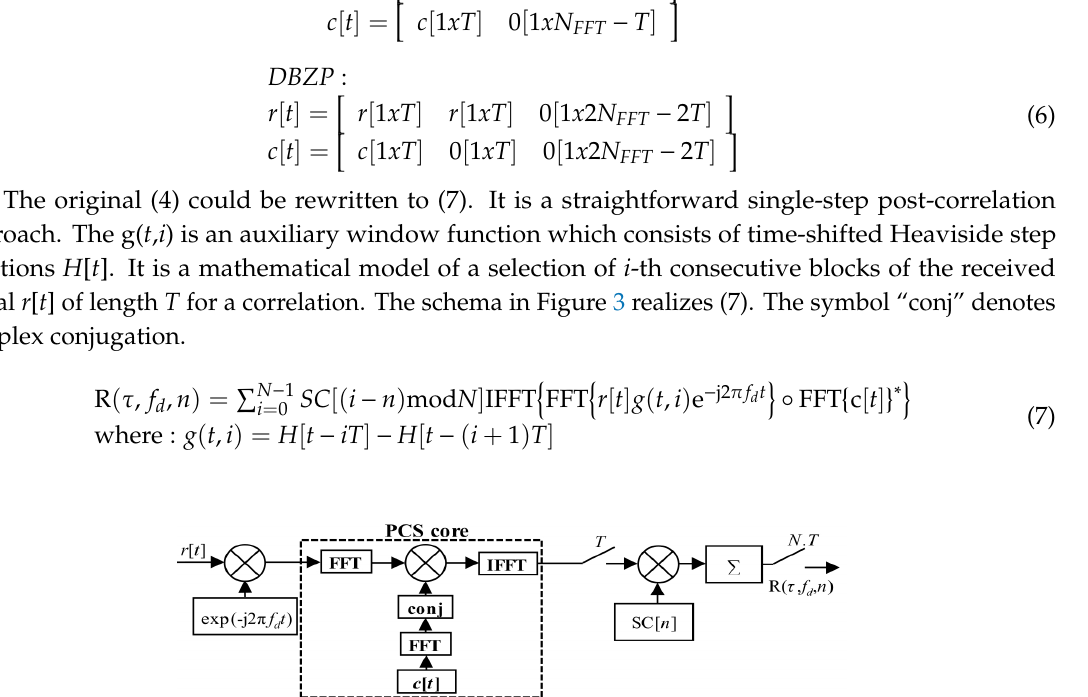
Figure 4. W -function ( left ), the effect of SC bit transition on the CAF ( middle ) and Doppler shift domain ( right ), for τ = (1/2) T .